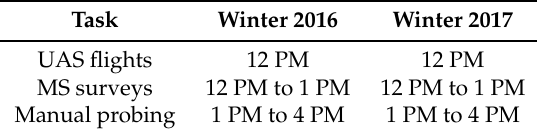
Table 1. Schedule of the two field surveys on snow (all times are